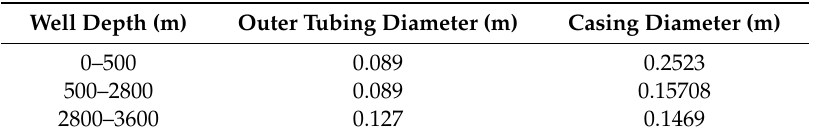
Table 1. Geometric parameters.